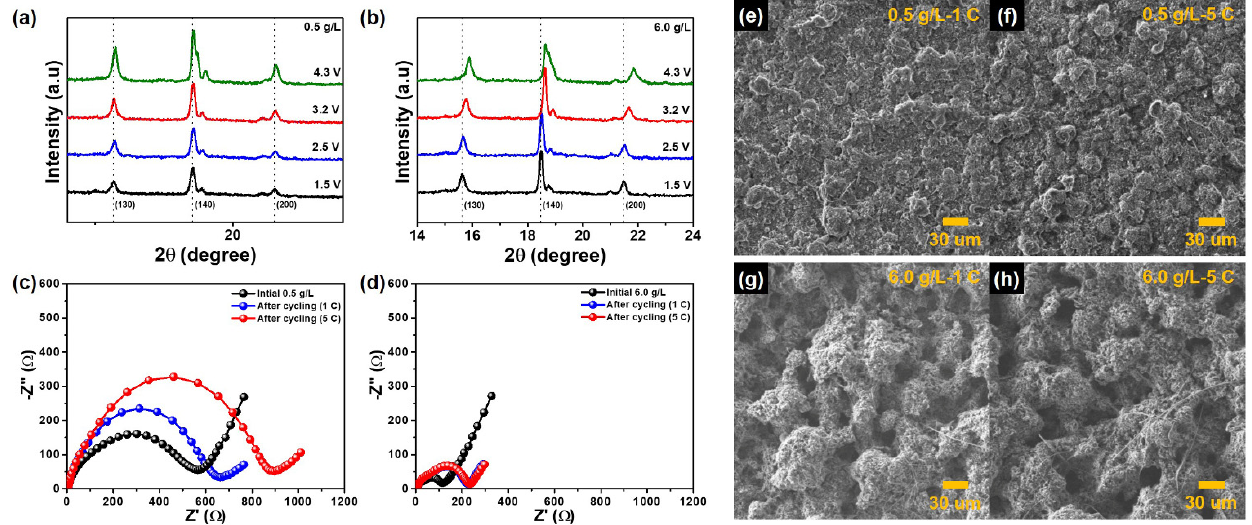
Figure 5. Ex situ XRD results of ( a ) 0.5 g/L electrode and ( b ) 6.0 g/L electrode, EIS Nyquist plot after 100 cycles at 1 and 5 C ‐ rate for ( c ) 0.5 g/L electrode and ( d ) 6.0 g/L electrode, and the resultant SEM images after high ‐ rate cycling measurement ( e , g ) 0.5 g/L electrode and ( f , h ) 6.0 g/L electrode).